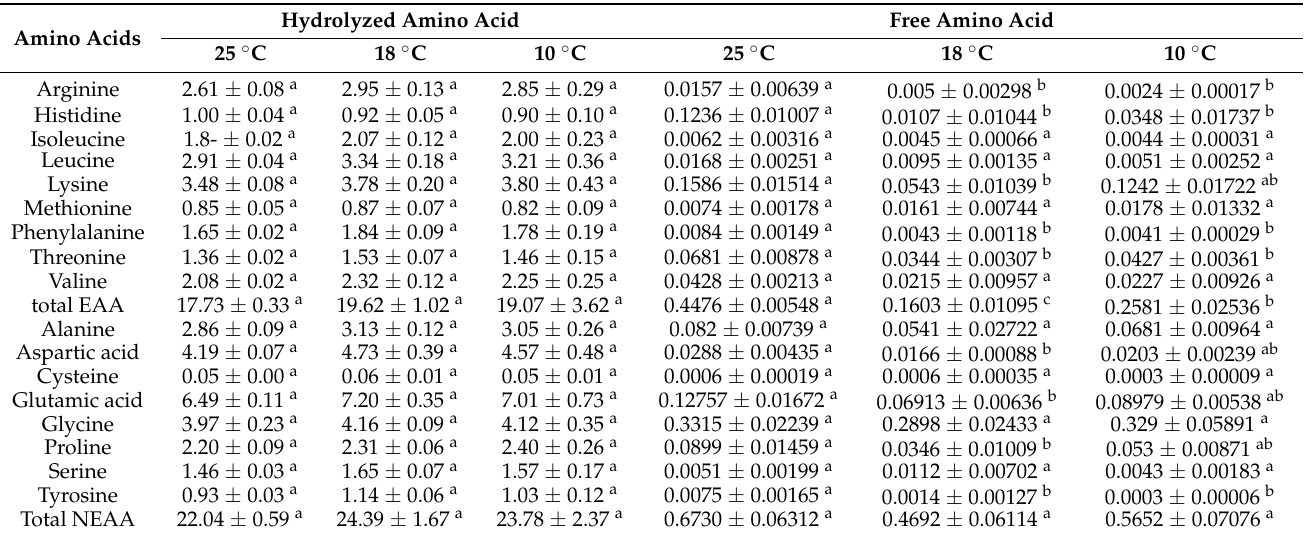
Table 1. Amino acid content (dry weight) after 2 days temperature stress (g/100 g sample). Note: values are mean and SEM, n = 3. Values in the same line with different superscripts are significantly different ( p < 0.05). Different superscript letters (a, b, c) represent the statistical difference ( p <